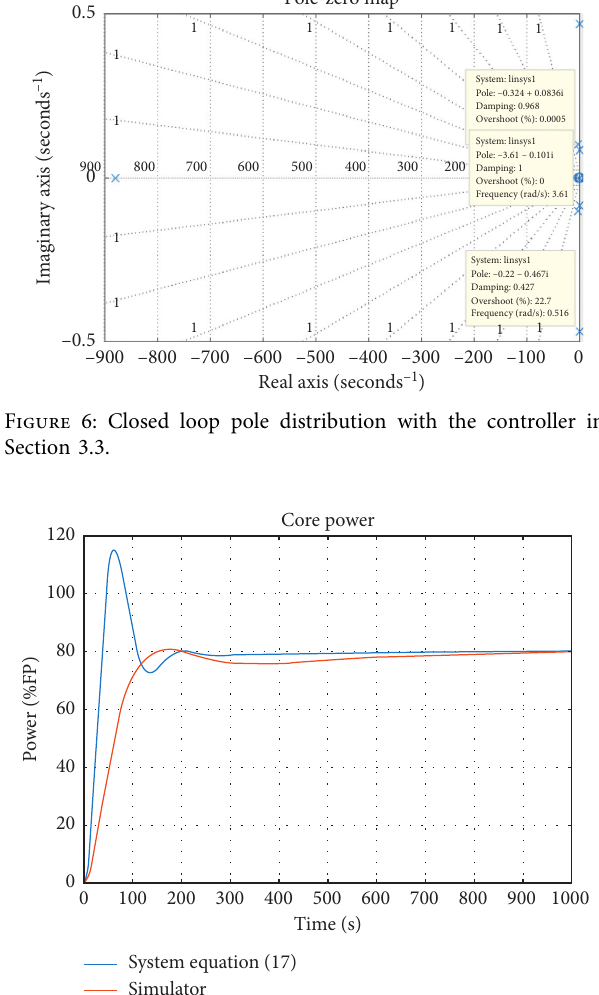
Table 1: Major parameters of CPR1000.